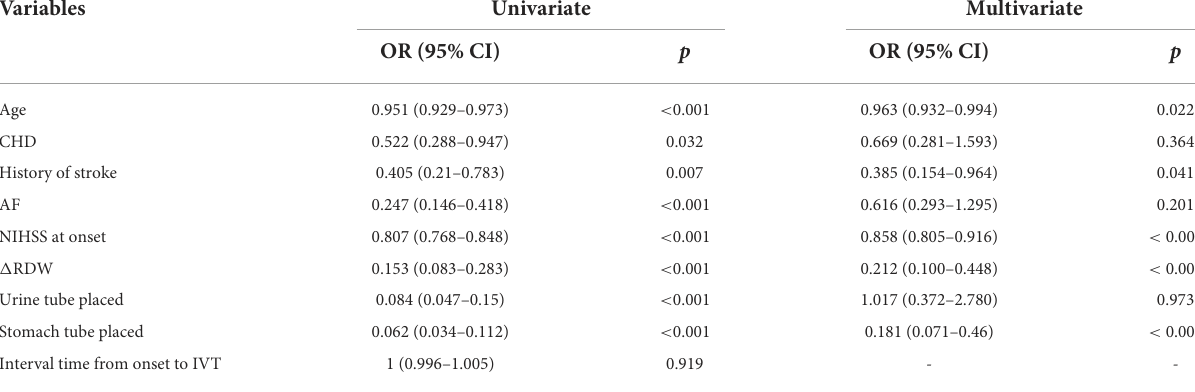
TABLE 2 Univariate and multivariate analysis of risk factors for poor neurological outcomes recovery.